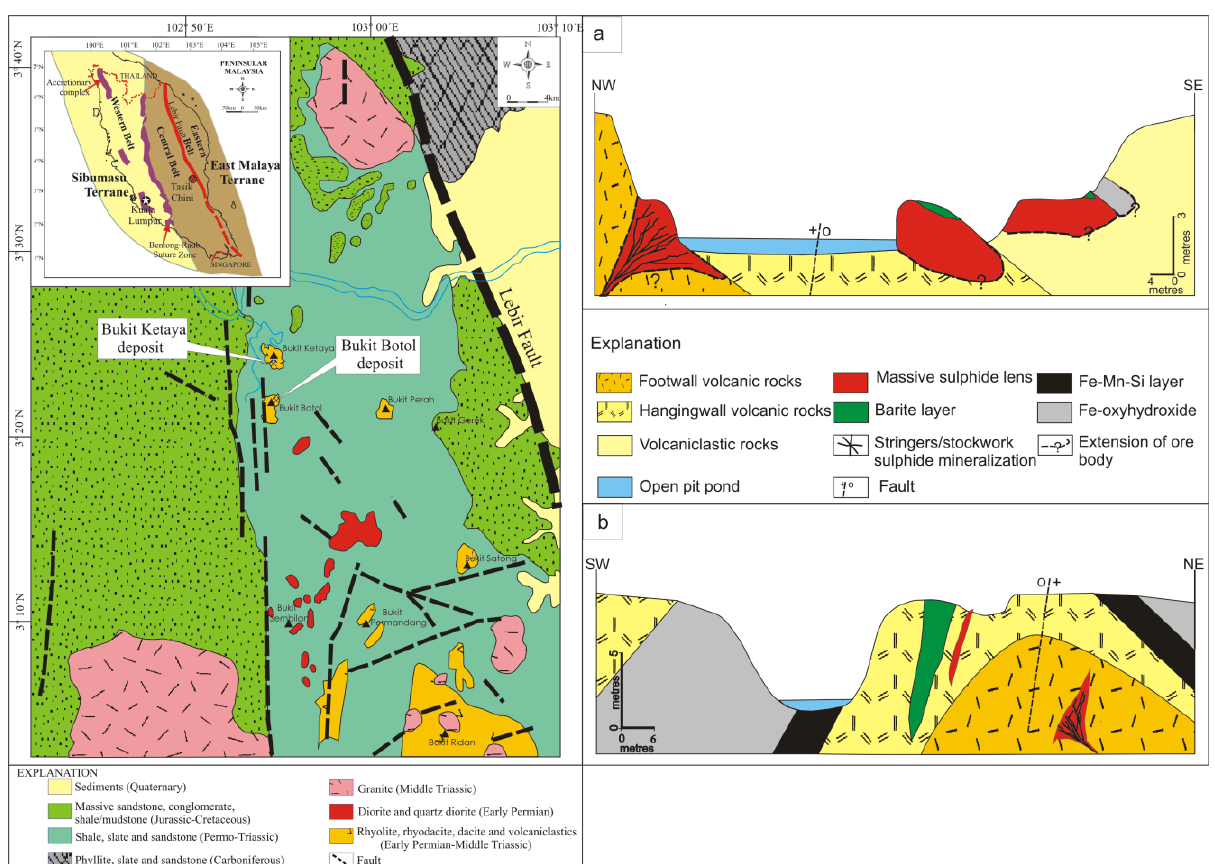
Figure 1. Map showing the location of Tasik Chini VHMS deposit on the East Malaya Terrane, and the location of Bukit Botol and Bukit Ketaya deposits in the regional geology the Tasik Chini area, Peninsular Malaysia (modified after [33]); ( a ) Representative cross-section through the Bukit Ketaya deposit showing the stratigraphic sequence and mineralisation styles (modified from [33]); ( b ) Cross-section of the Bukit Botol deposit showing the stratigraphic sequence and mineralisation styles (modified from [33]).